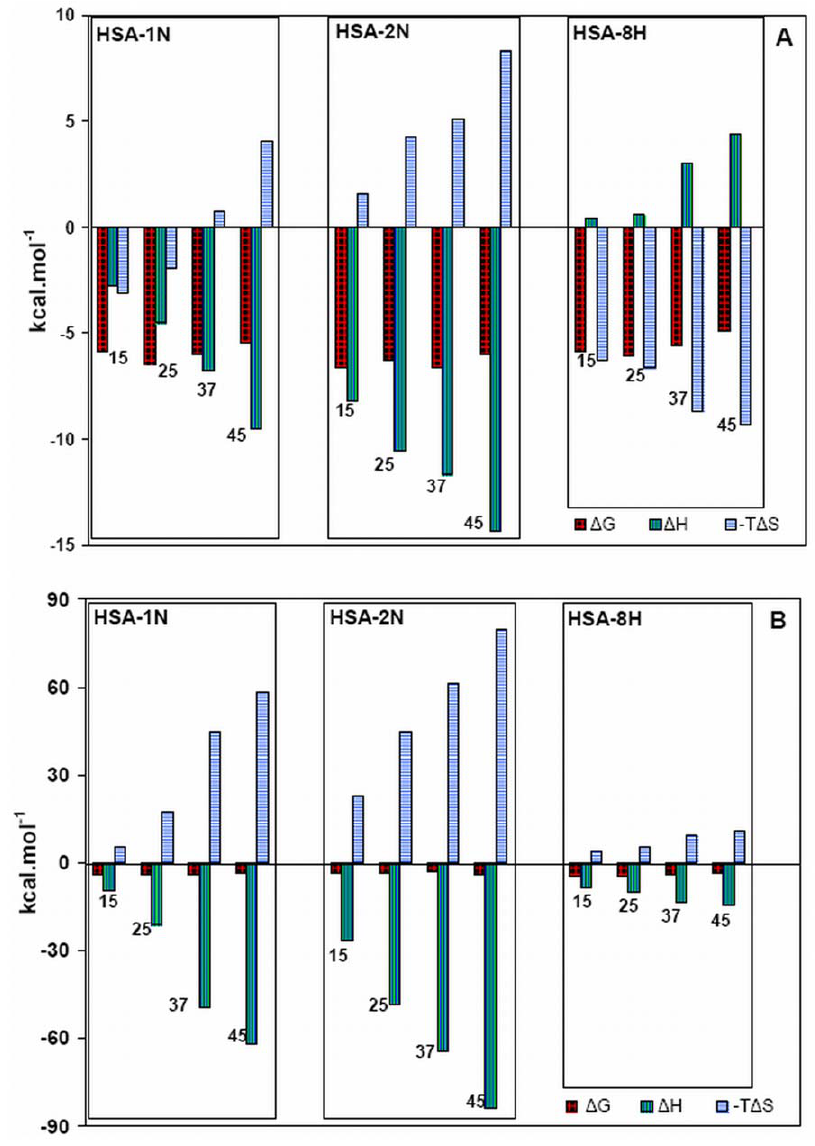
Figure 10. Thermodynamic signatures for 1N, 2N and 8H associations to HSA (A) for binding site 1 and (B) for binding site 2. The corresponding temperatures in u C are